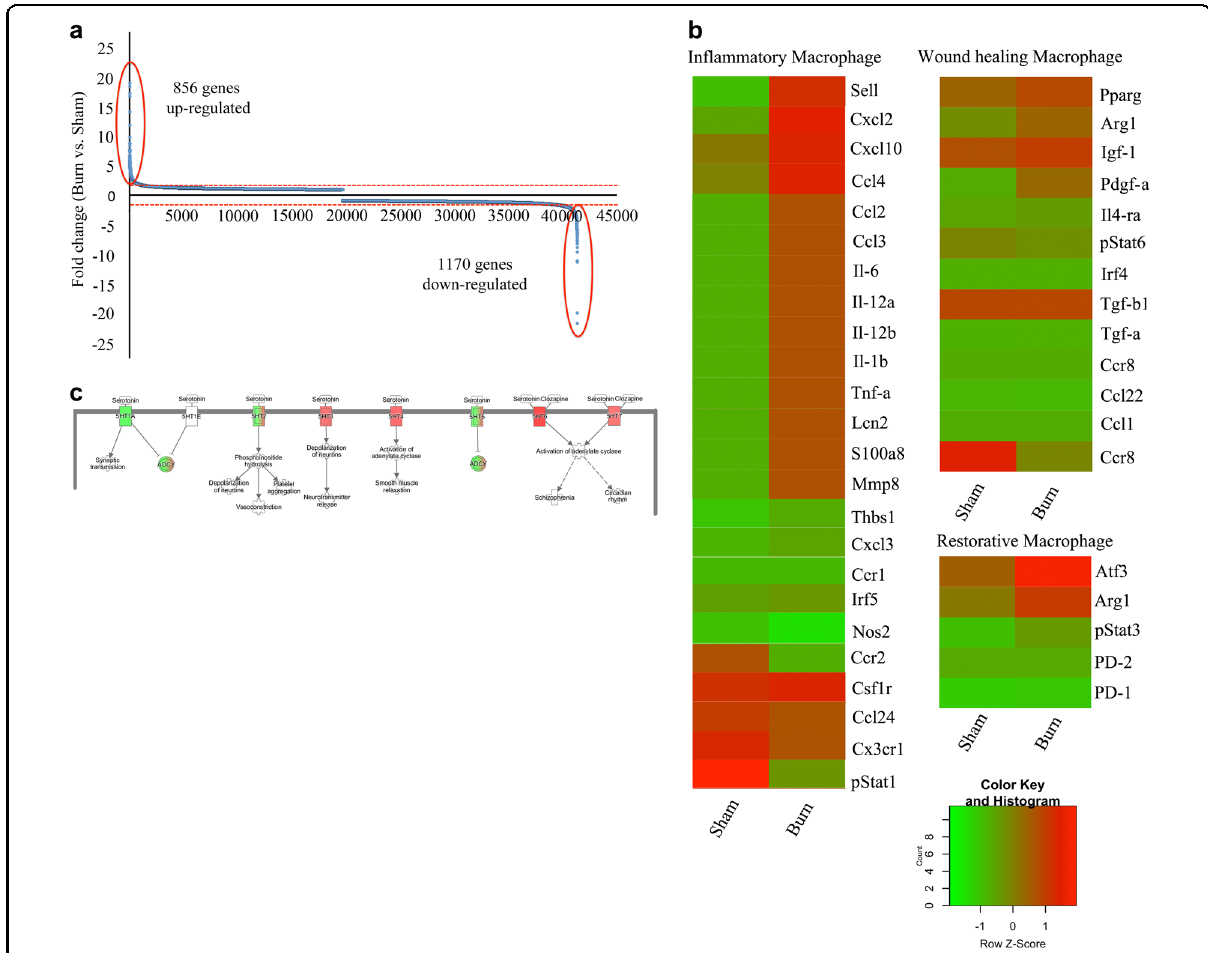
Fig. 4 EYFP + cells show a gene expression pro fi le favoring a pro-in fl ammatory phenotype post-thermal injury . a There is a differential gene expression in ~4.5% of genes when comparing burn and sham groups. b Pathway analysis shows upregulation of cytokines essential for stellate cell activation and ( c ) modulation of several components of the serotonin pathway, including the 5HT 2A/2C